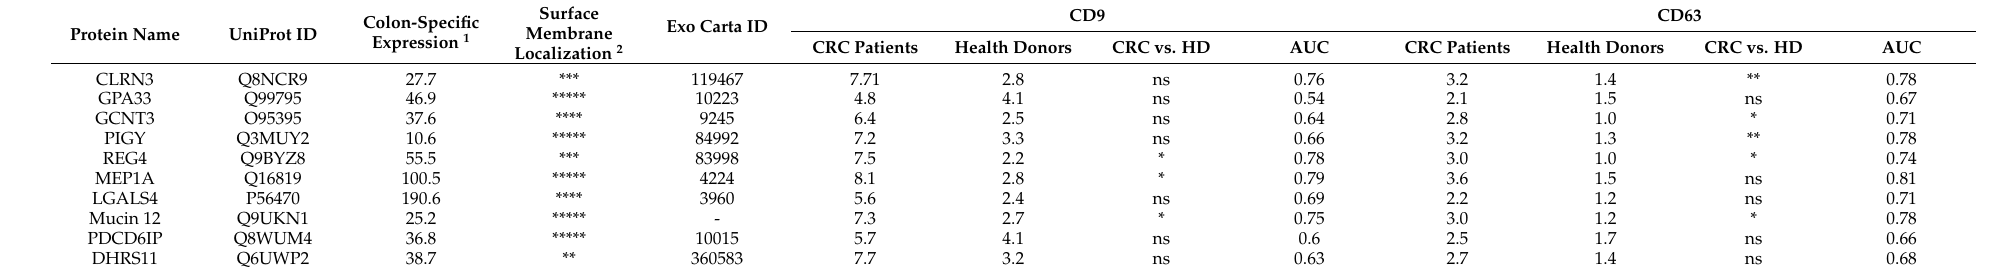
Table 2. List of colon epithelium-specific protein surface